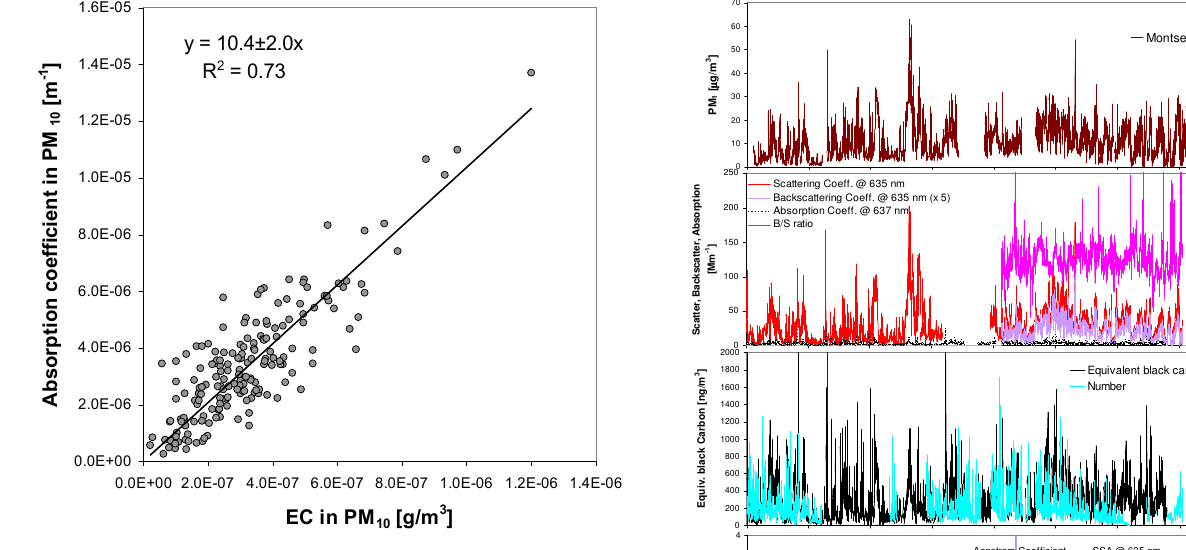
Fig. 2. Correlation between Absorption coefficient from MAAP (637nm) and 24h off-line elemental carbon (EC) concentrations from PM 10 filters.